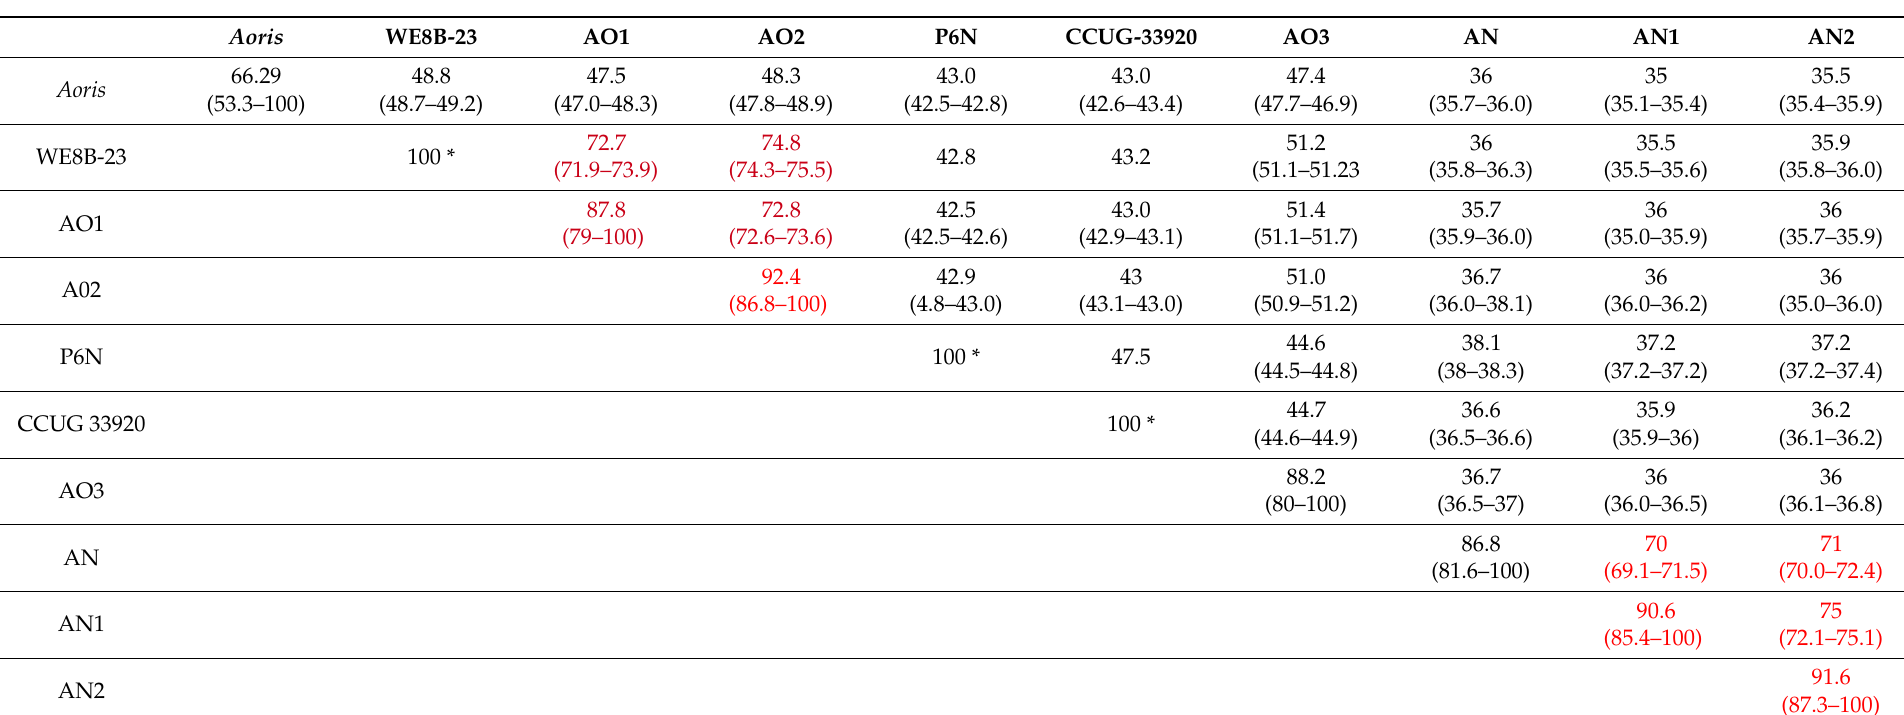
Table 1. Summary of Final DDH